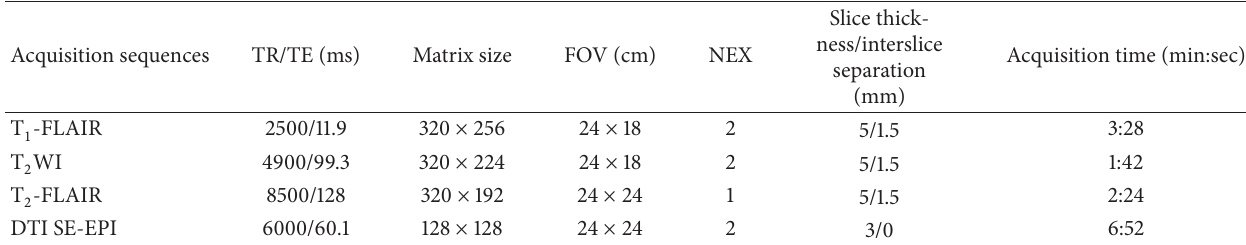
Table 1: The parameters of each acquisition sequence in MRI